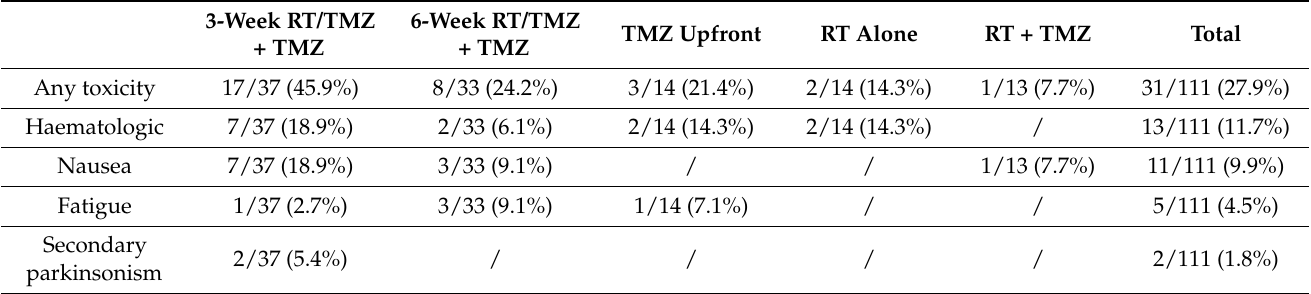
Table 5. Treatment-Related Adverse